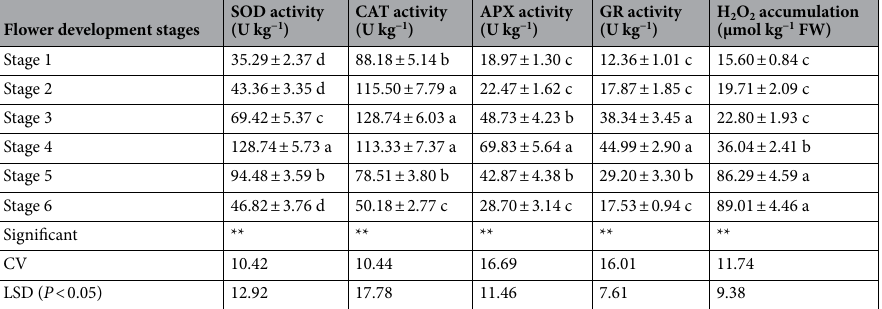
Table 2. SOD, CAT, APX and GR activity accompanying by endogenous H 2 O 2 accumulation during rose flowers development from bud opening to petal senescence. Data shown are mean values of n = 3, and the error bars represent standard errors of the means. Mean values followed by different letters indicate they are different by LSD test at P < 0.05.